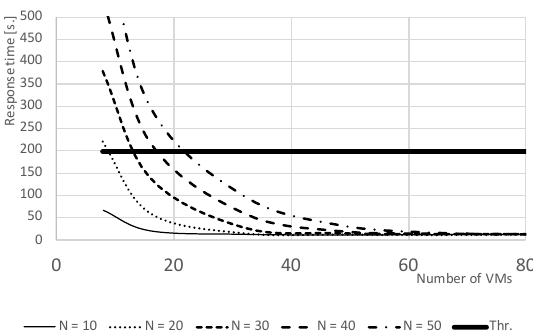
Figure 12. Determining the optimal number of VMs to obtain an average response time R below a given threshold ( τ = 200s in this